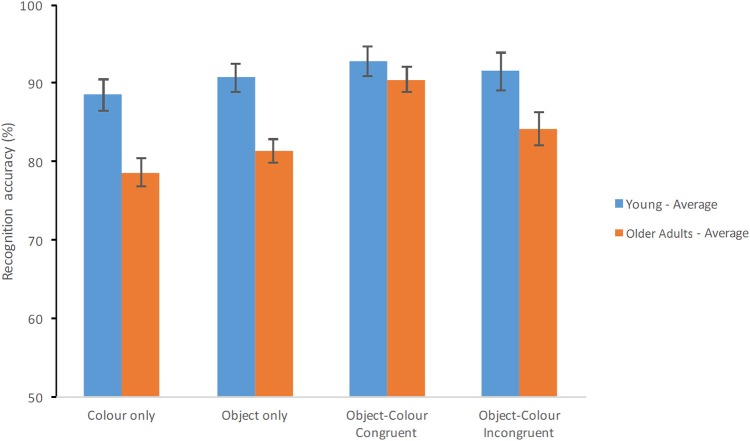
Percentage of correct recognition averaged across test delays when the analysis was controlled for education. Average scores of young adults and healthy older adults are shown for each test condition (Error bars represent the standard error of the mean).